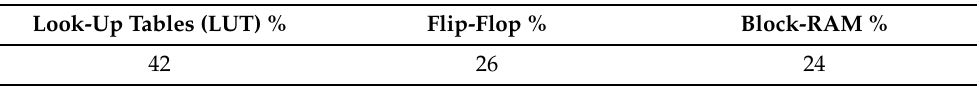
Table 1. Device utilization of the integrated RCT and GCT algorithms for the XCVU9P C2104 package FPGA.